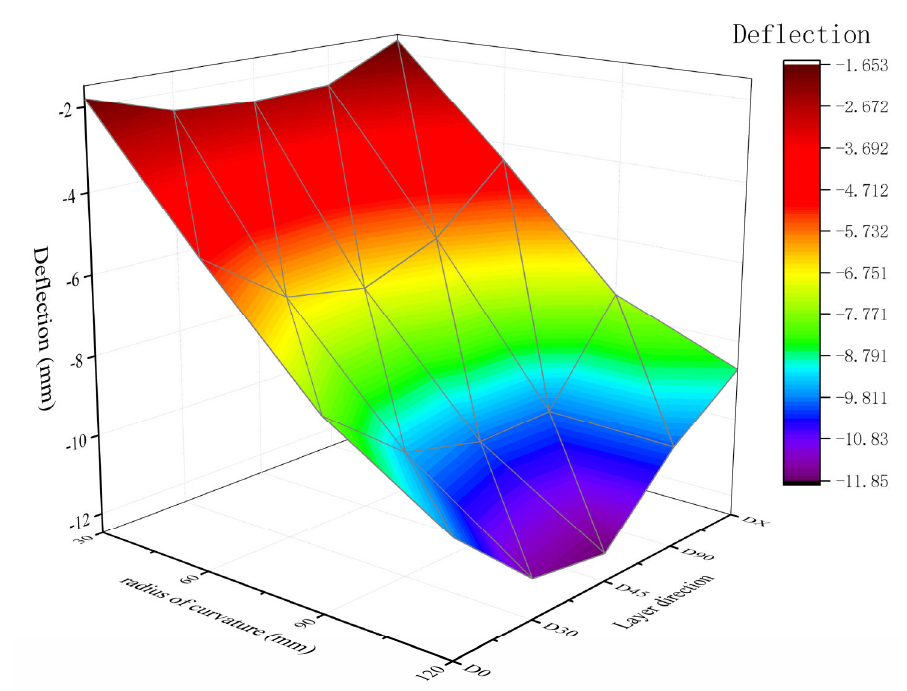
Figure 22. Maximum deformation vs. fiber layering direction and radius of curvature.